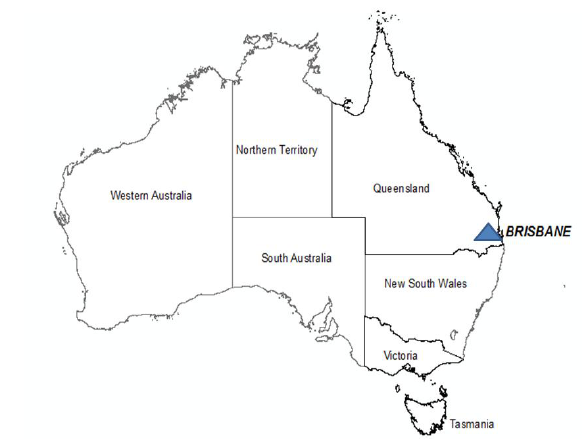
Figure 1. Location of study site